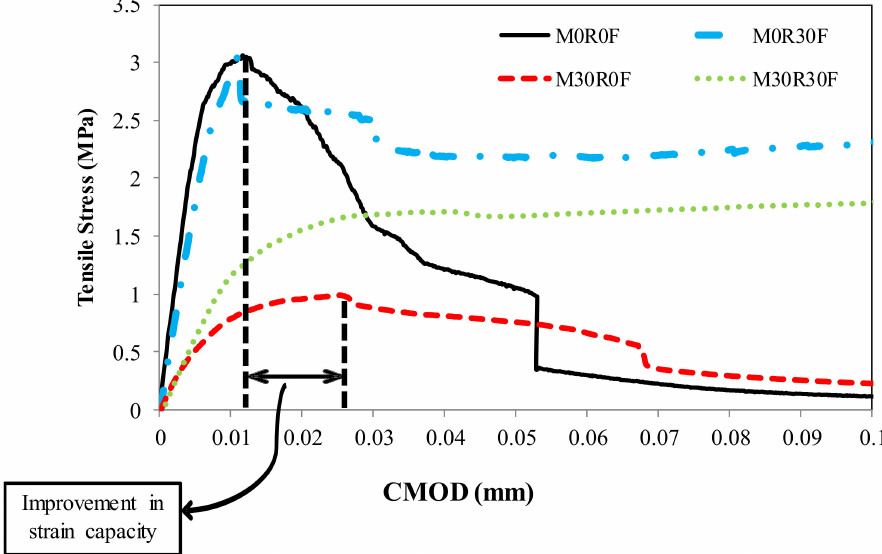
Figure 13. Impact of rubber aggregates and fibres on strain capacity and on residual post-peak strength (enlarged